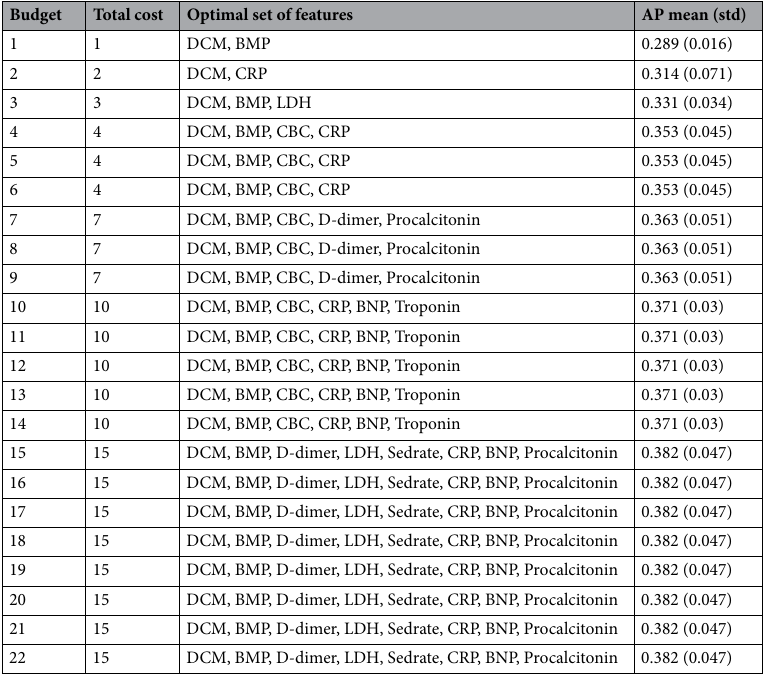
Table 5. Optimal set of features at different budget levels for predicting composite ventilation. Total cost is the sum of the cost of each feature group in the selected set.